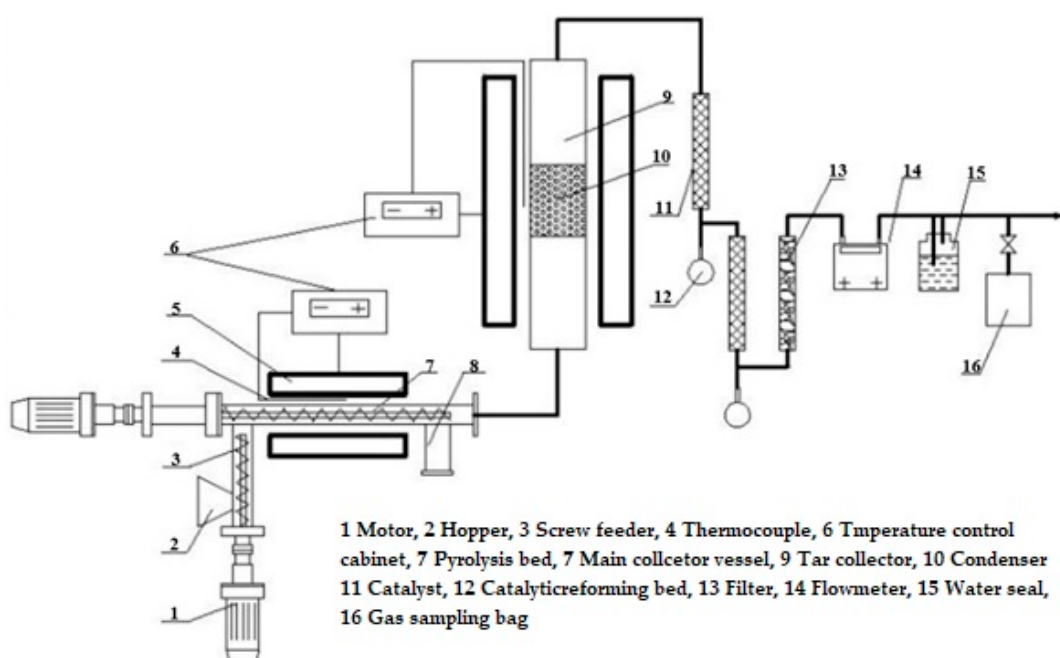
Figure 7. Schematic diagram of the two-stage catalytic pyrolysis reactor.